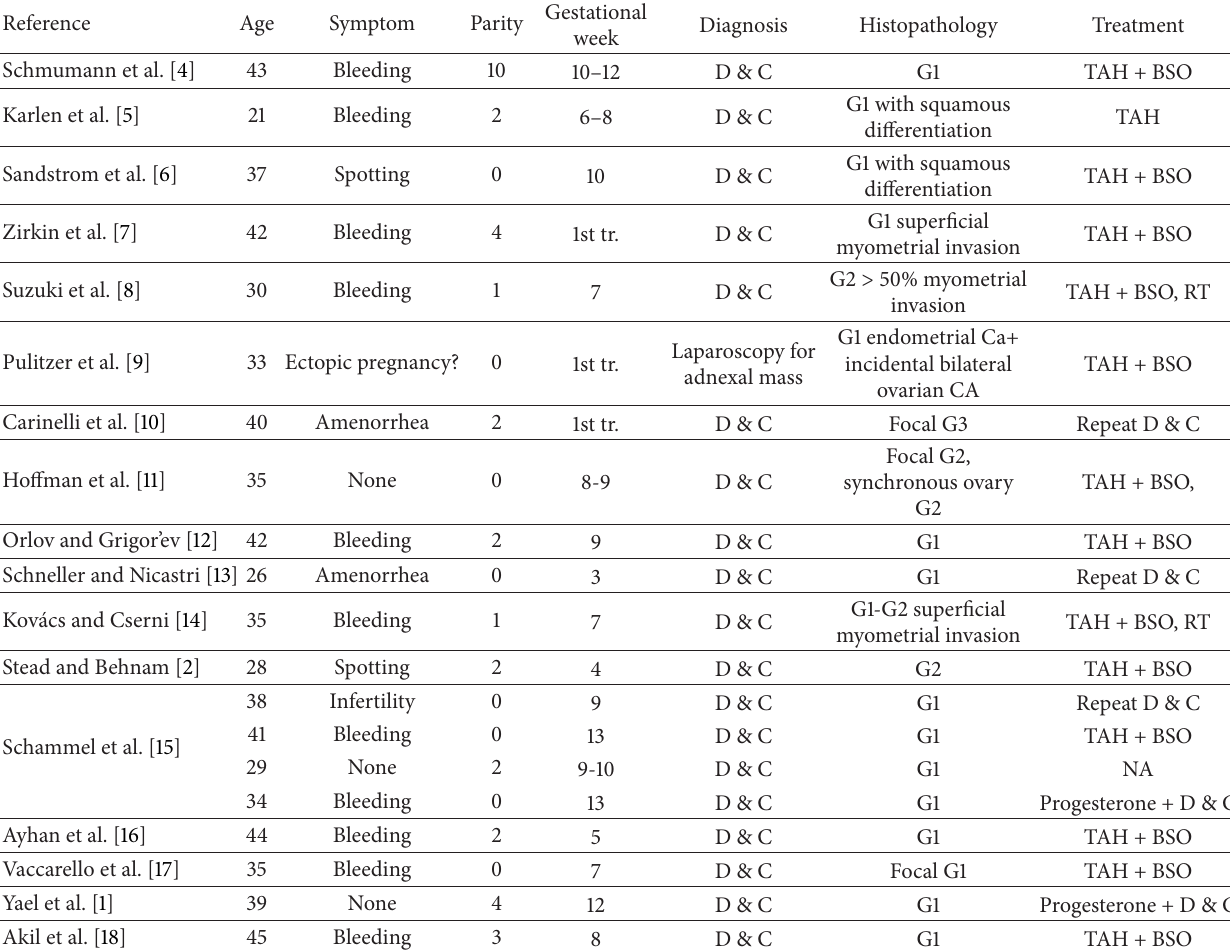
Table 1: List of the cases with pregnancy associated with endometrial carcinoma in the first trimester.